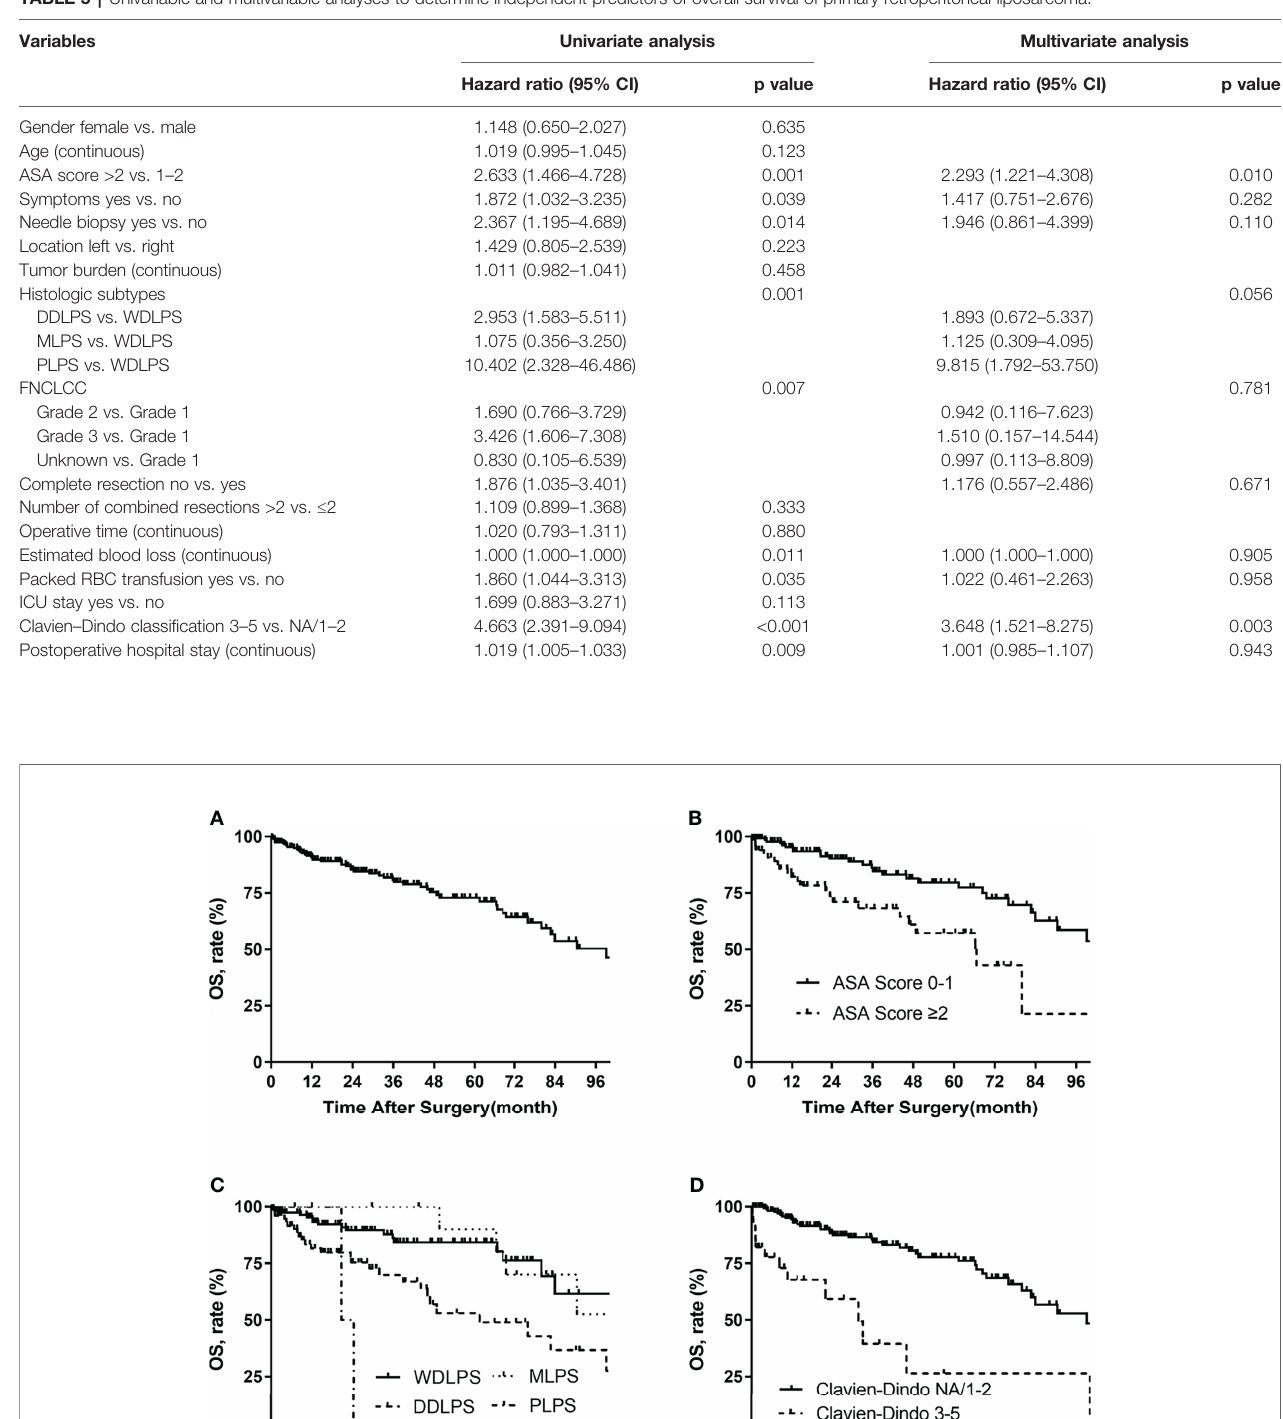
TABLE 5 | Univariable and multivariable analyses to determine independent predictors of overall survival of primary retroperitoneal liposarcoma.